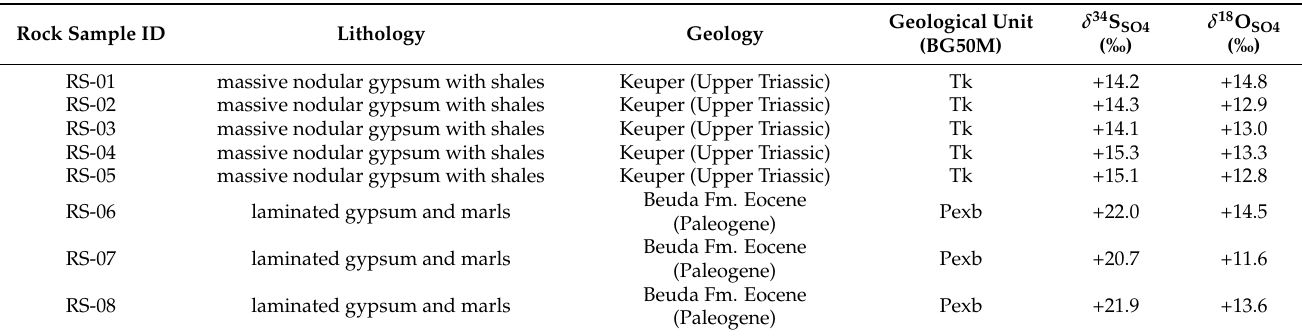
Table A7. Rock samples collected for the characterization of S and O isotopic composition of from sulfate in Triassic and Tertiary gypsum in the PCM study area.